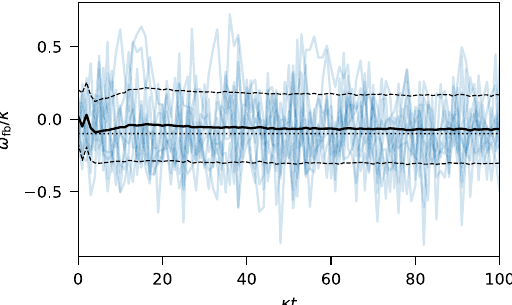
FIG. 5. Feedback parameter ω fb obtained via the RL agent as a function of time, both for a few sample trajectories (correspond- ing to blue lines with different shades of blue) and averaged over 5000 trajectories (black line). The dashed black lines show the standard deviation. The average of the RL is close to the value − ω , yielding the maximum squeezing (dotted black line). The other physical parameters are set as in the previous